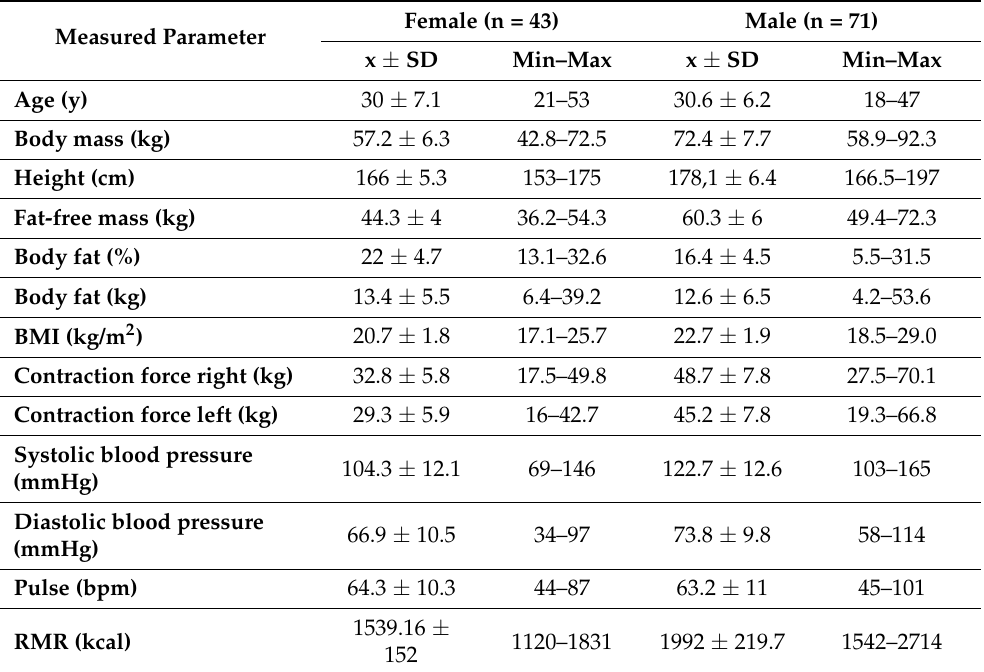
Table 2. Characteristics of the study group.